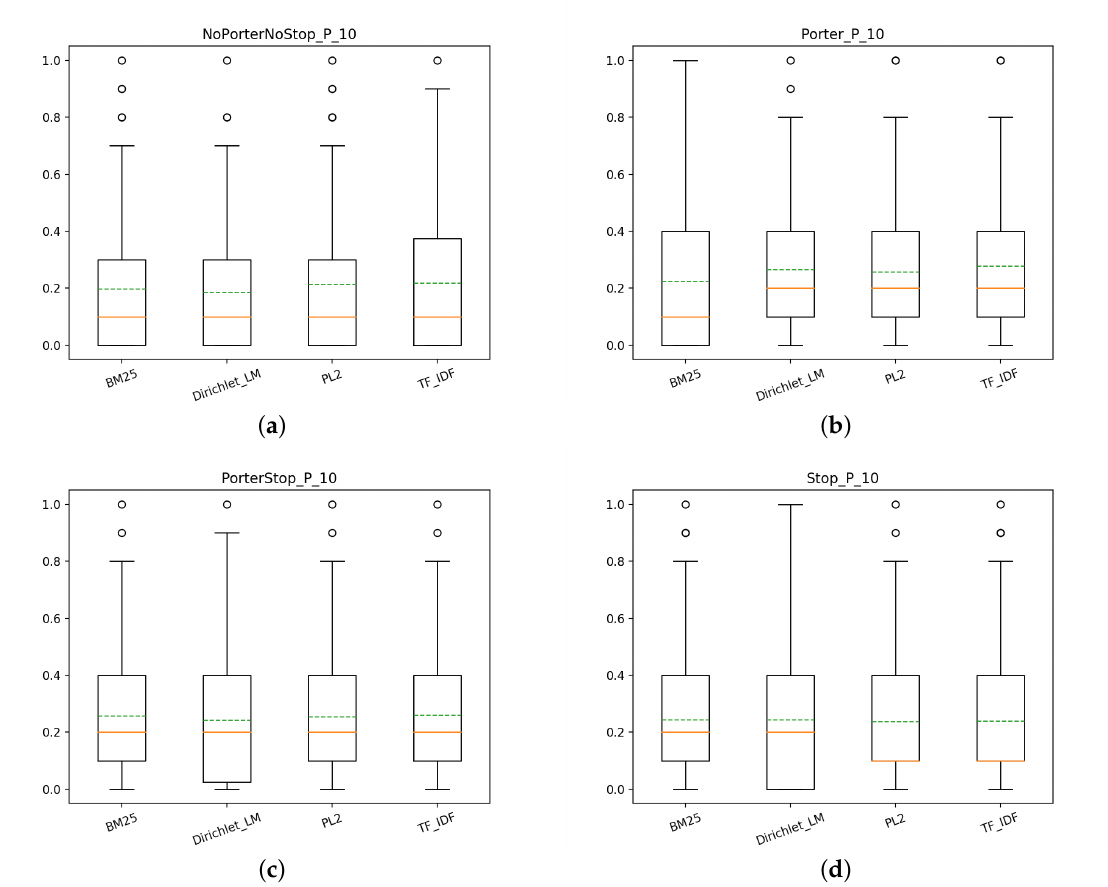
Figure 6. T2: box plots for P@10 of the different models for each index: ( a ) NoPorterNoStop indexs, ( b ) Porter index, ( c ) PorterStop index, ( d ) Stop